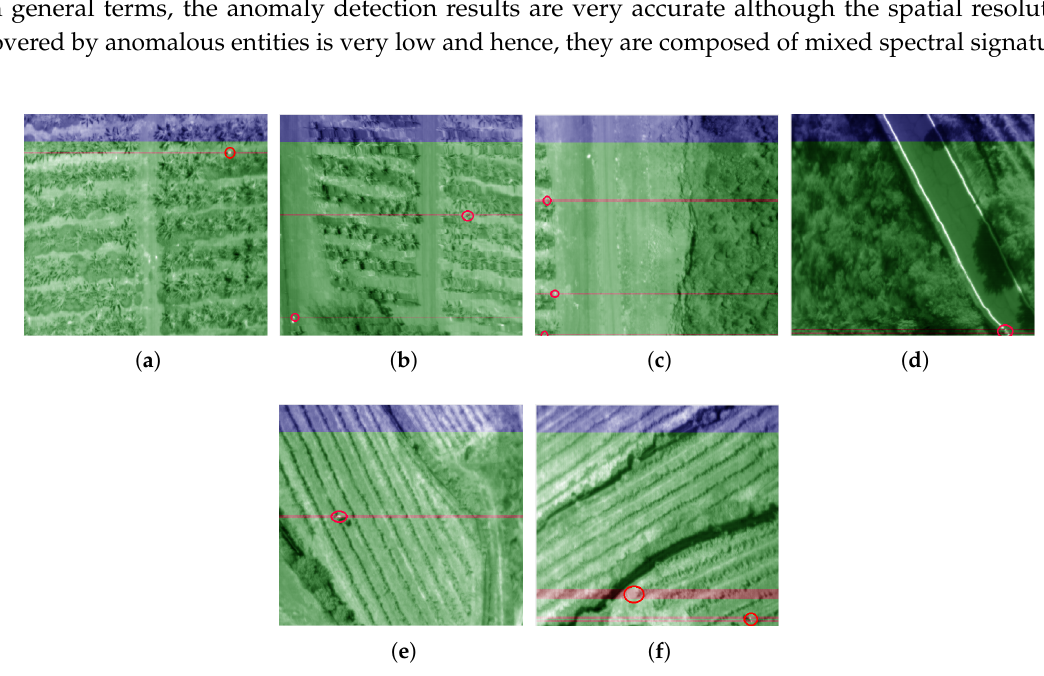
Figure 7. Anomaly detection results for input parameters N bits = 12, BS = 1024 and CR = [12,16,20]. Lines in blue color represent the n f frames employed to estimate the background distribution. Green lines represent the hyperspectral frames free of anomalies. Red lines represent those frames identified by our proposal to be corrupted by anomalous pixels. Pixels enclosed in red circles represent the anomalous pixels detected by our proposal. ( a ) Image 1; ( b ) Image 2; ( c ) Image 3; ( d ) Image 4; ( e ) Image 5; ( f ) Image